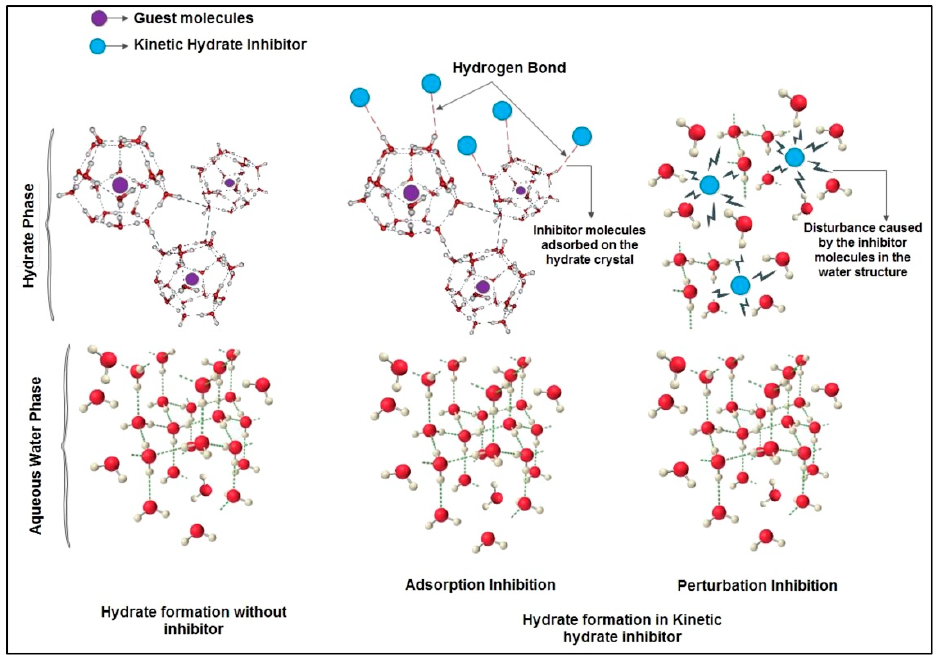
Figure 2. Schematic diagram of kinetic hydrate inhibition by adsorption and perturbation [36].